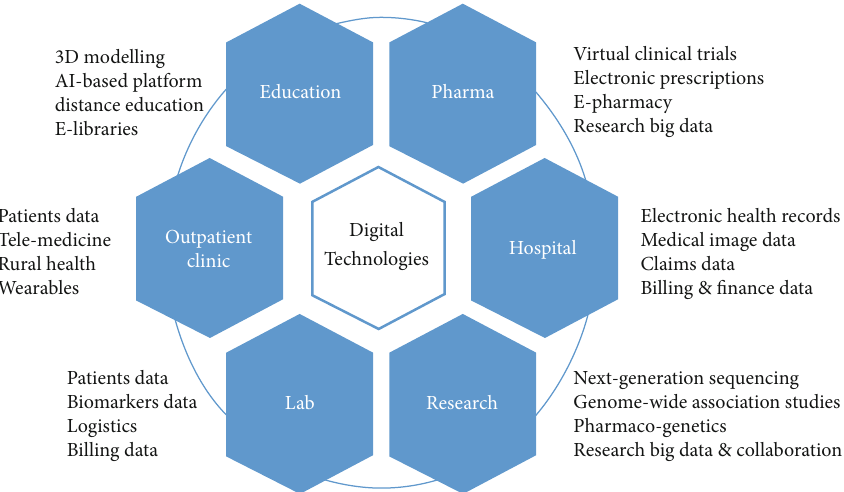
Figure 1: Scheme of main applications of digital technologies in healthcare.